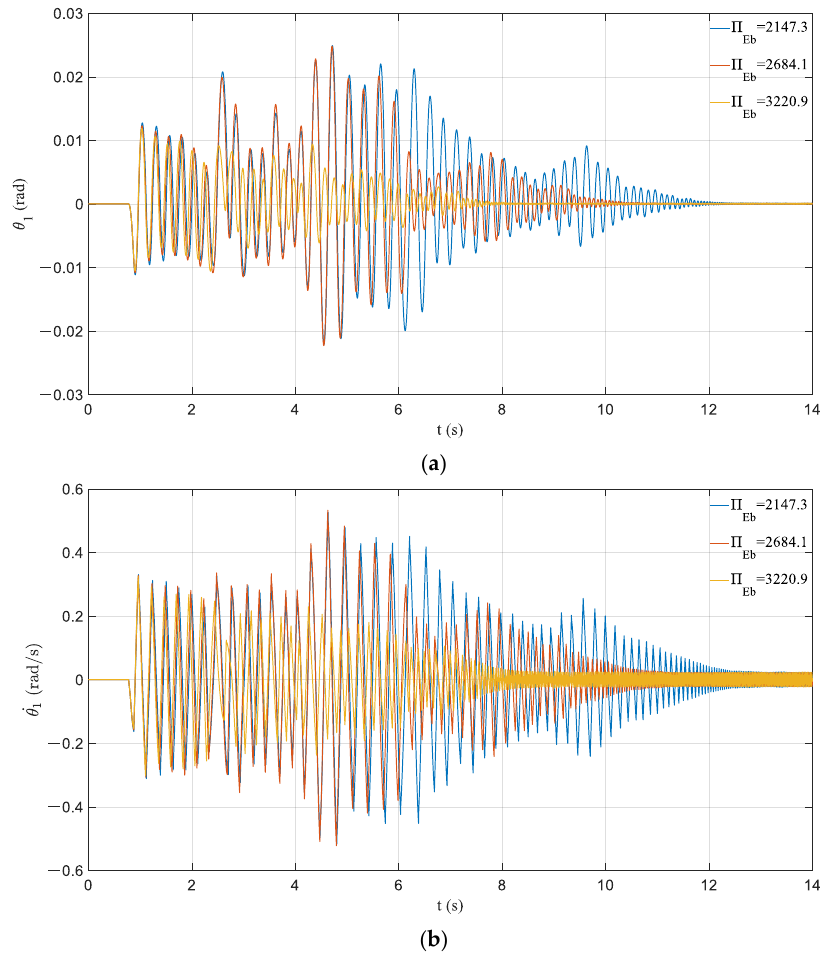
Figure 19. Effect of variation in